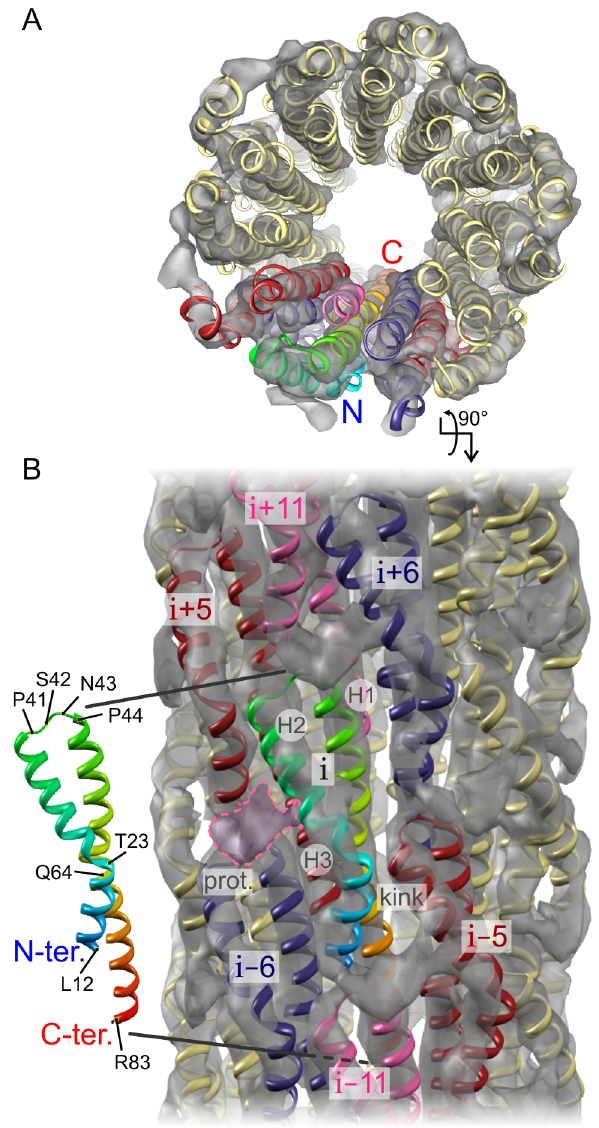
Figure 5. Structural model of the T3SS Shigella needle. A , Top and B , side views of the T3SS needle assembly of Shigella flexneri . The homology model of the 29-subunit MxiH needle assembly generated by Rosetta modeling (cartoon representation) shows a correlation of 0.66 with the 7.7-A˚ cryoEM density map (grey surface). Using the nomenclature of Fujii et al. , the EM density regions H1, H2 and H3 are indicated for the central subunit (i), as well as the kink in region H3. The first 11 N-terminal residues are not depicted due to the poor sequence homology of the rigid-extended segment (Fig. 2); however the protrusion in the EM map at subunit (i), labeled prot. and highlighted by a purple dashed contour trace, may be well explained by the N-terminus of subunit (i + 5). The central subunit (i), colored as in Fig. 1 B , forms a lateral interface with subunits (i 6 5), in red, and subunits (i 6 6), in dark blue. The axial interface is formed with subunits (i 6 11) shown in pink.